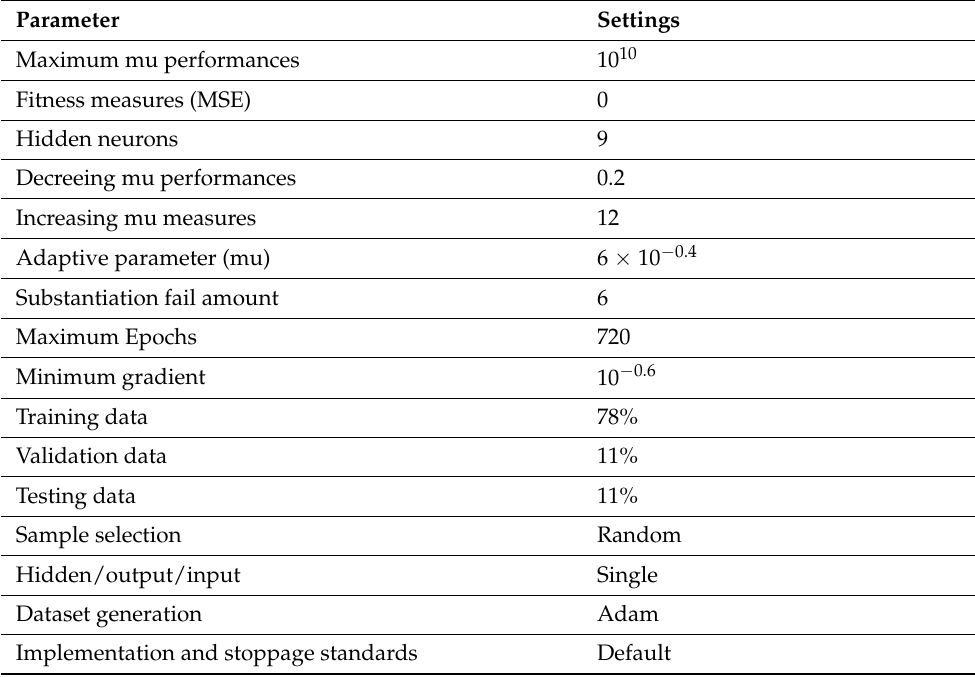
Table 1. Values of the parameter to perform the stochastic